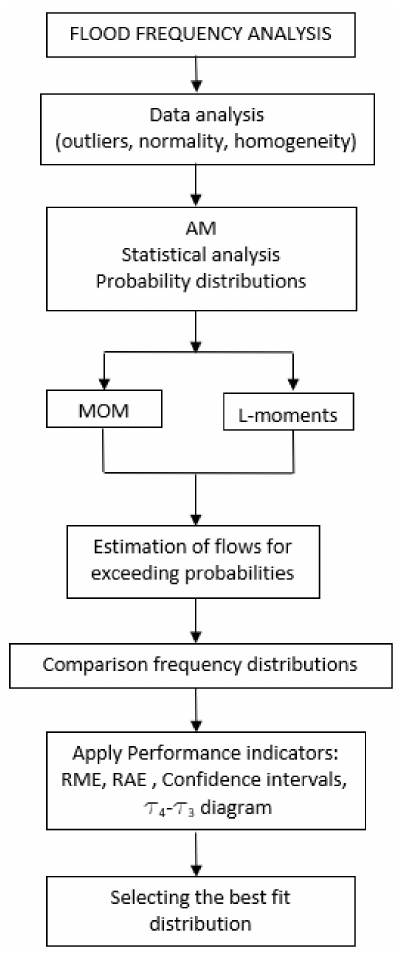
Figure 2. Methodological